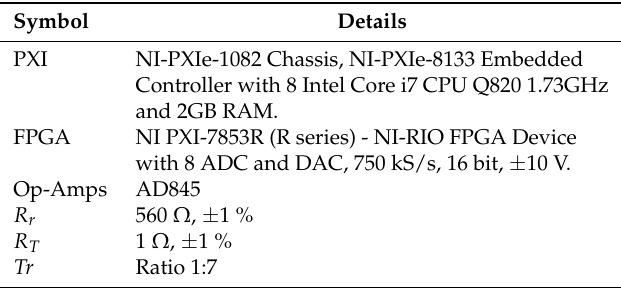
Table 3. Configuration of the digital